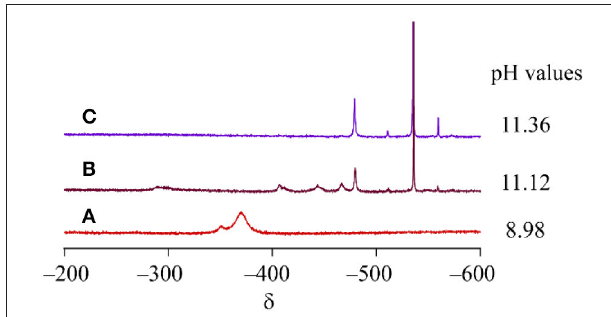
FIGURE 2 | 51 V NMR spectra of the reaction mixture of [Co(tacn)(H 2 O) 3 ] 3 + and VO 43 − . The molar ratio is (A) 1:1, (B) 0.5:1, (C) 0.25:1, respectively.